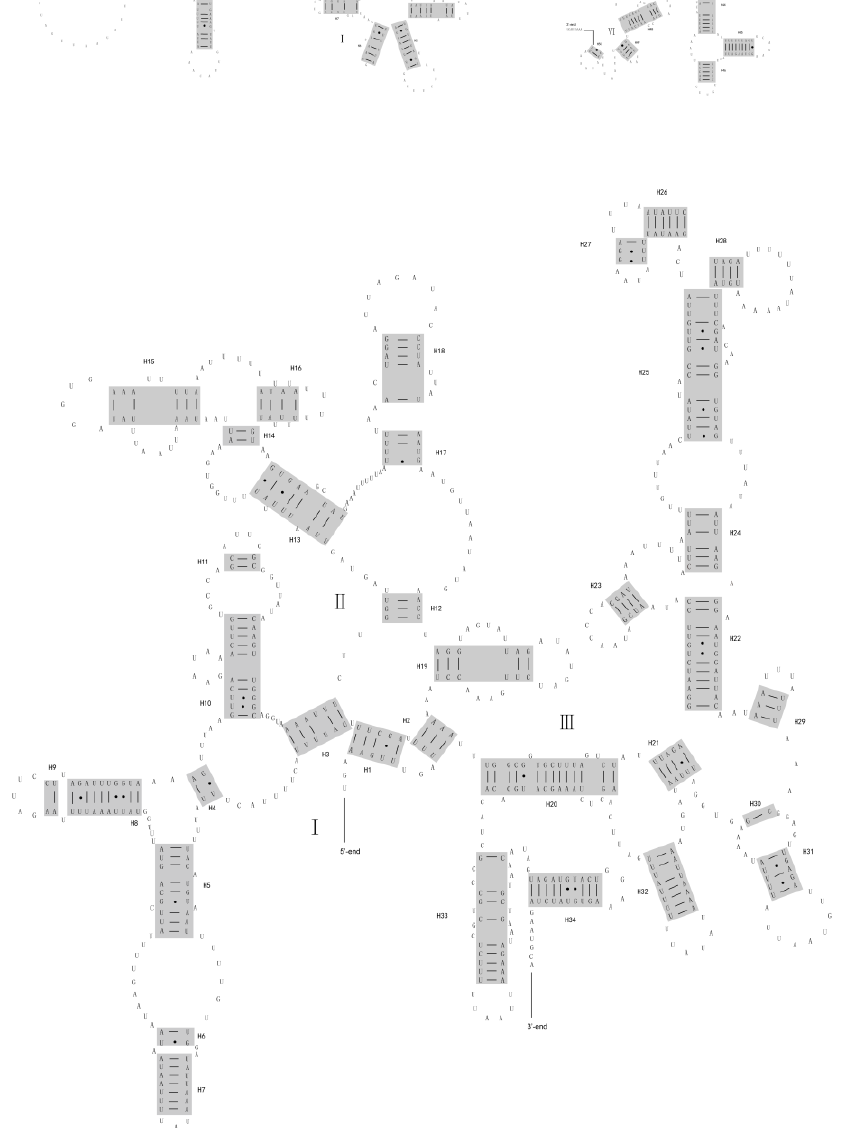
Figure 2. The secondary structures of ( A ) rrnL and ( B ) rrnS predicted for Dendroleon pantherinus